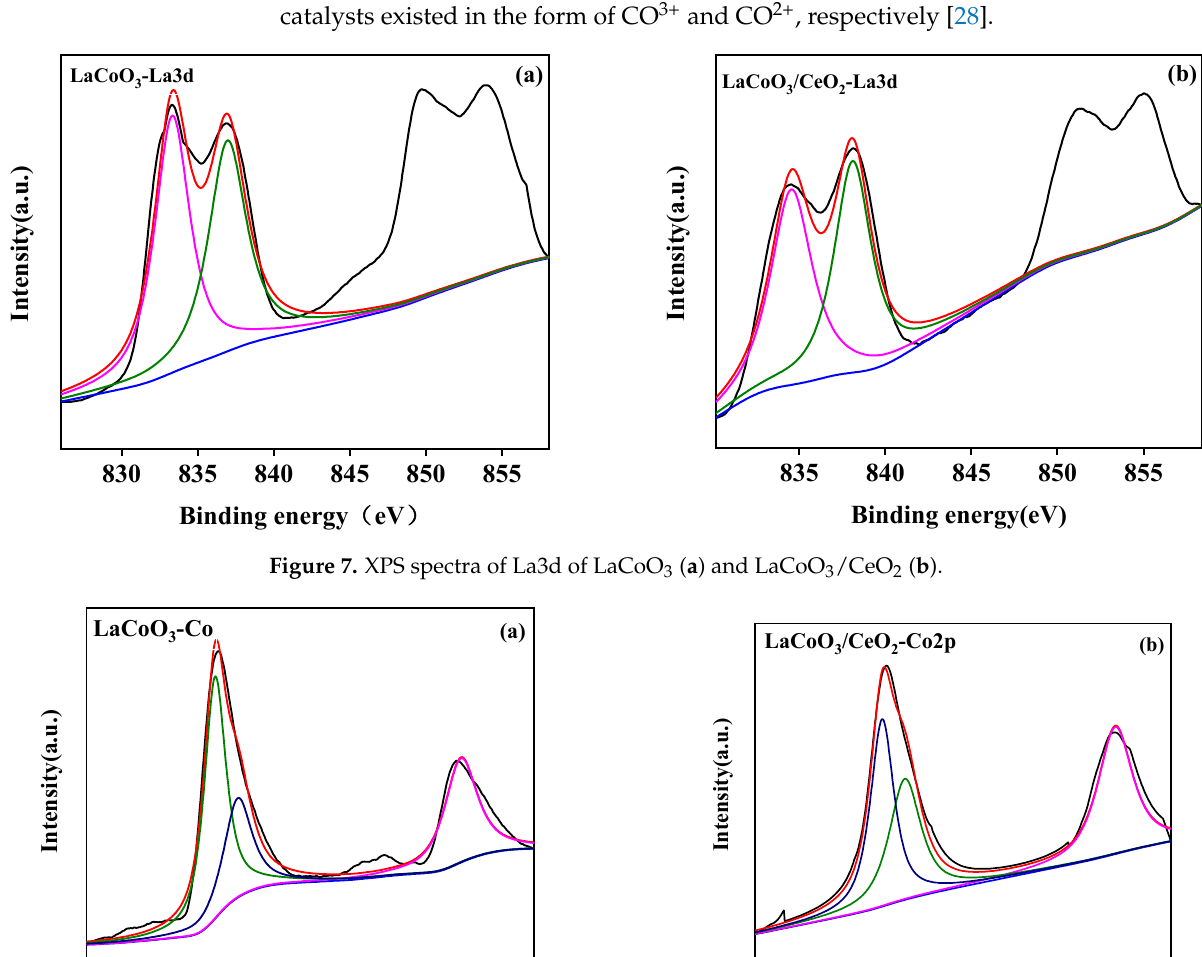
Figure 9. XPS spectra of O1s of LaCoO 3 ( a ) and LaCoO 3 /CeO 2 ( b ).